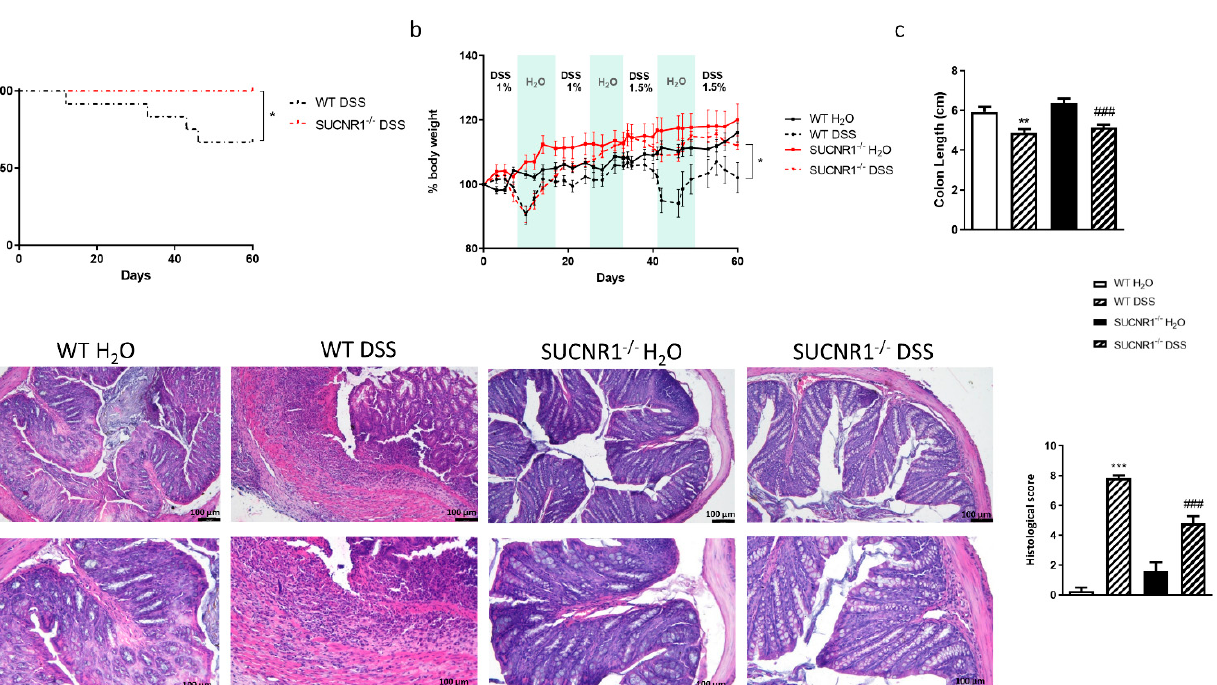
10 of 20 Figure 2. SUCNR1 mediates basal and LPS-stimulated inflammatory pathways in intestinal epithe- lial cells. ( a ) HT29 cells treated with LPS 0.1 µg/mL during 24h and graphs show mRNA and protein expression of SUCNR1 ( n = 5). Image of a representative Western Blot of one independent experi- ment. ( b ) HT29 cells transiently transfected with a specific siRNA against SUCNR1 or ctrl and treated with LPS 0.1 µg/mL during 24 h. Graphs show protein expression of pERK-1/2, ERK-1/2, pNF к B and NF к B ( n = 6) and mRNA expression of IL1B , iNOS , IL6 and TNF-a ( n = 5). Image of a representative Western Blot of one independent experiment. ( c ) HT29 cells treated with vehicle or LPS (with or without the MEK inhibitor U0126 10 µM) over 2 h and graphs show protein expression of pERK-1/2, ERK-1/2, pNF к B, NF к B and I к B ( n = 5). Image of a representative Western Blot of one independent experiment. ( d ) Graph shows succinate levels in supernatant of HT29 cells ( n = 4). In all cases, bars in graphs represent mean ± SEM. * p < 0.05, ** p < 0.01 and *** p < 0.001 vs. vehicle cells. # p < 0.05 and ## p < 0.01 vs. the respective siCtrl cells. $ p < 0.05 vs. U0126 nontreated cells.